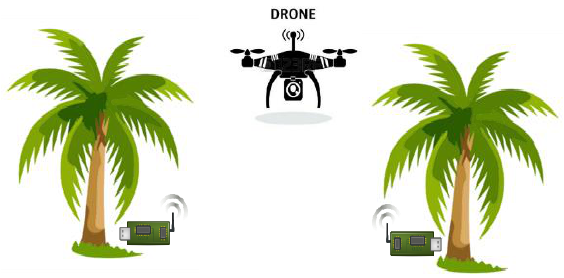
Figure 3. Using drone in DTN for precision agriculture in a palm oil plantation.